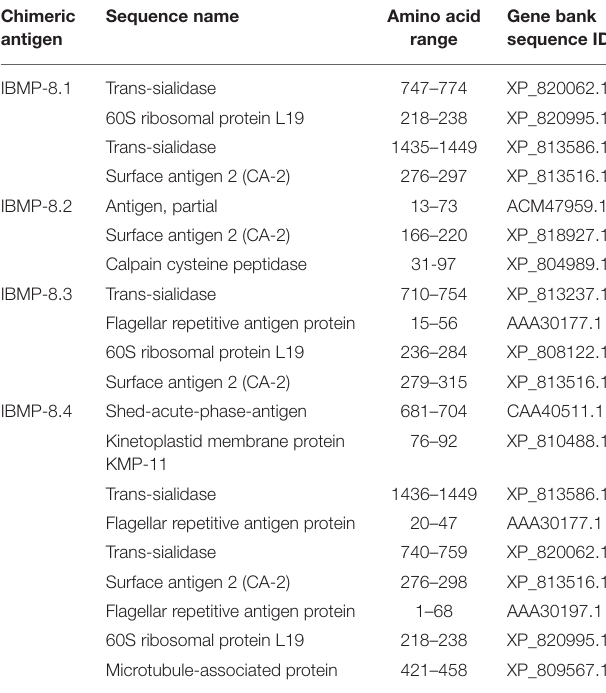
TABLE 1 | Constitution of the IBMP chimeric recombinant